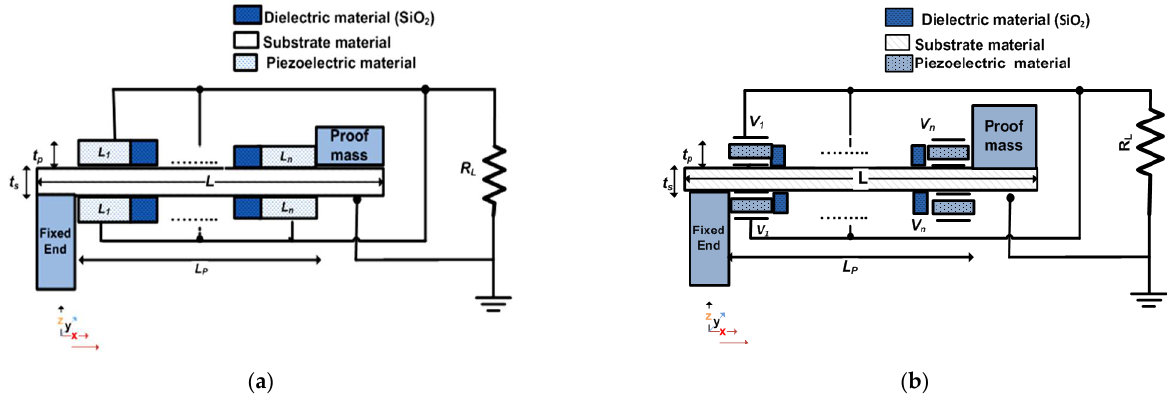
Figure 3. ( a ) Demonstration of the proposed structure with n piezoelectric material segments and ( b ) electrical connection.